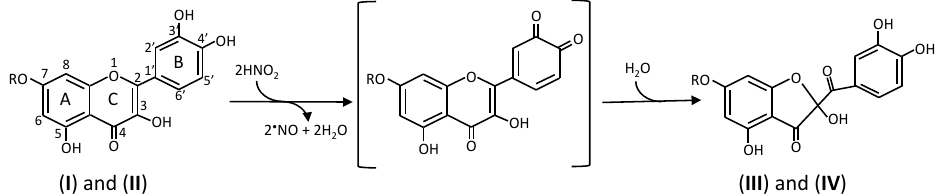
Figure 1. Reactions of quercetin I (R = H) and its 7- O -glucoside II (R = glucose) with nitrous acid. ( III ) 2-(3,4-dihydroxybenzoyl)-2,4,6-trihydroxy-3( 2H )-benzofuranone, ( IV ) 2-(3,4-dihydroxybenzoyl)-2,4-dihydroxy-3( 2H )-benzofuranone 6- O -glucoside. The compounds in brackets are unstable quinones of I and II .